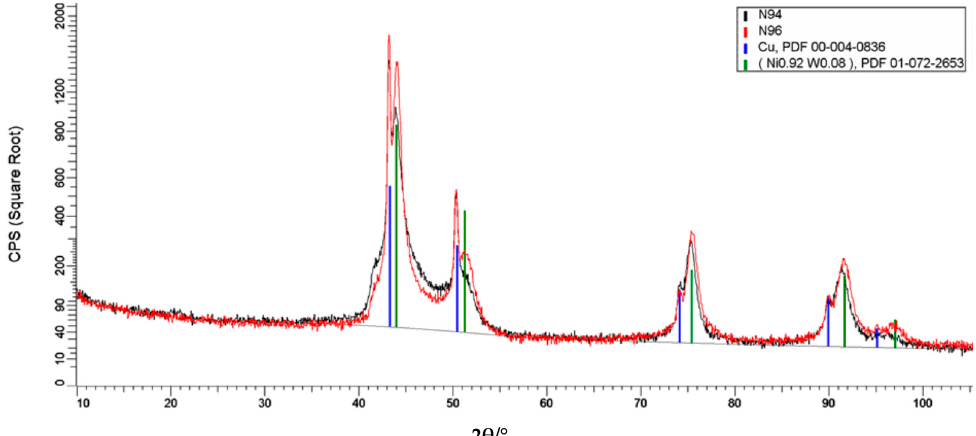
Figure 5. SEM images of Ni–W coatings of a 5 μ m in thickness made in electrolytes with pH 9.5 in the PC mode with different current densities, A·cm − 2 : ( a ) 0.01, ( b ) 0.02, ( c ) 0.05, ( d ) 0.1.